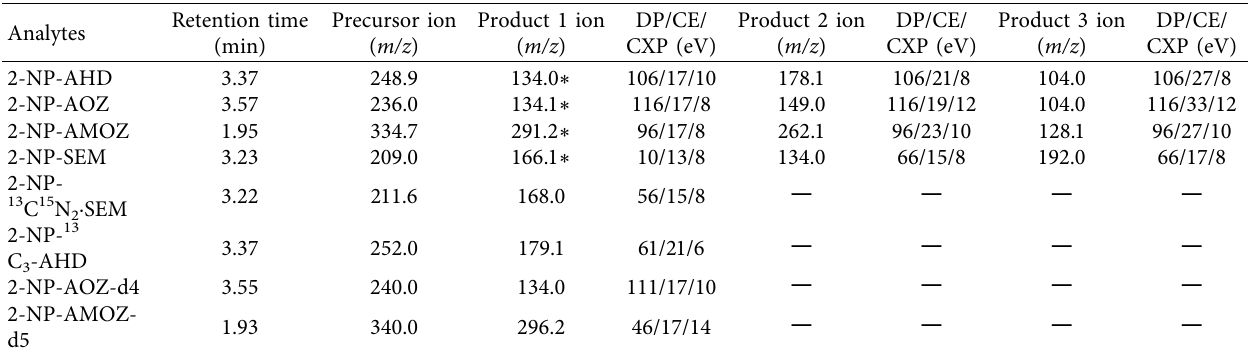
Table 1: Mass spectrometry parameters for the optimal operational analysis of the derivatized NF metabolites.